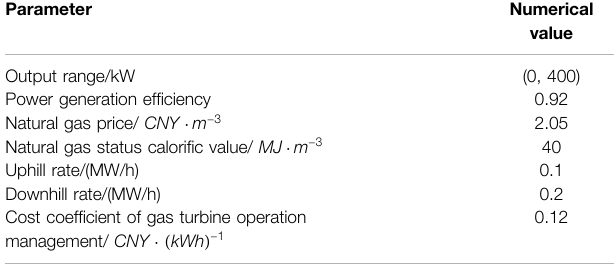
TABLE 3 | Speci fi c parameters of the gas turbine.